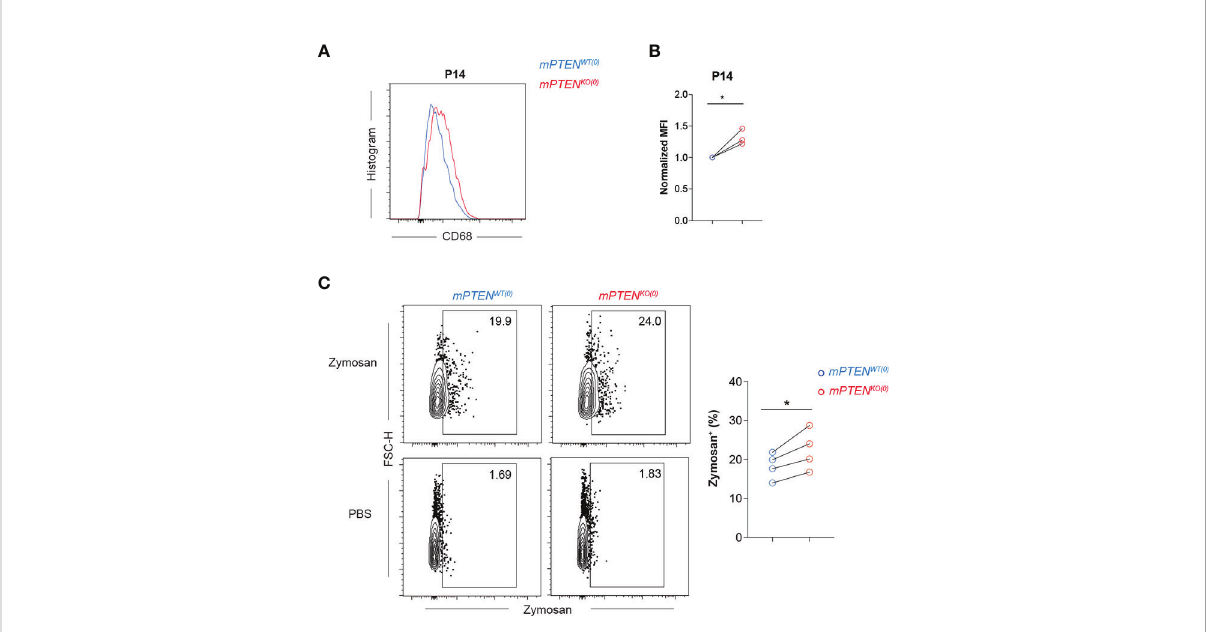
FIGURE 3 Microglia without PTEN are more phagocytic (A, B) Histograms (A) and normalized MFI (B) of CD68 staining on mPTEN WT(0) (blue) and mPTEN KO(0) (red) microglia at P14. Each pair of line-connected dots represents one of the three independent experiments conducted. In each experiment, cortical microglia of each genotype were pooled from 2 male mice. (C) Contour plots showing freshly isolated microglia at P7 that were incubated in vitro with 0.2 mg/ml zymosan or PBS for 1.5 h. The scatter plot shows summary data of the percentage of zymosan- containing microglia of the indicated genotype. Each dot represents one experiment, and in each experiment microglia of cerebral cortex were pooled from 4-5 male mice. Lines denote mean ± s.e.m. *P < 0.05, by paired t